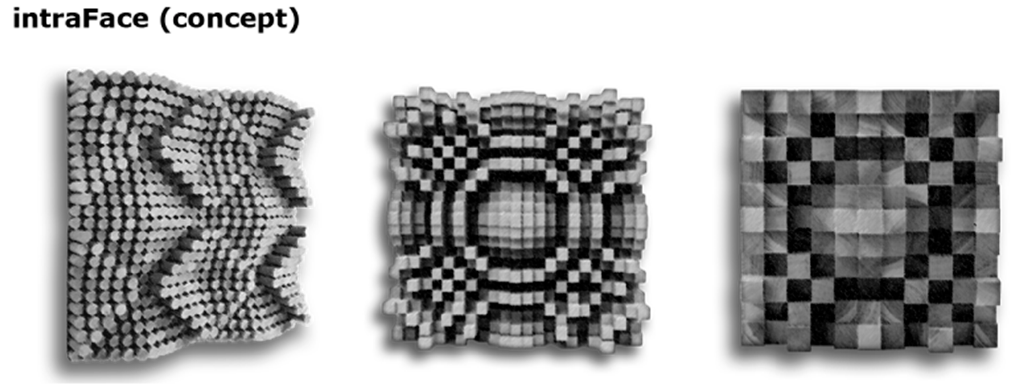
Figure 2. Conceptual sketches of the internal physical room interface (also known as intraFace).